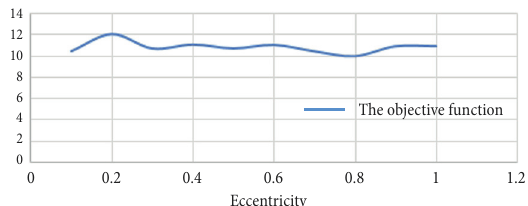
Experiment Finite element analysis